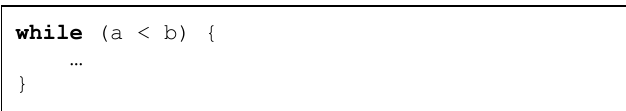
Fig. 8. Second branching example decompilation result.